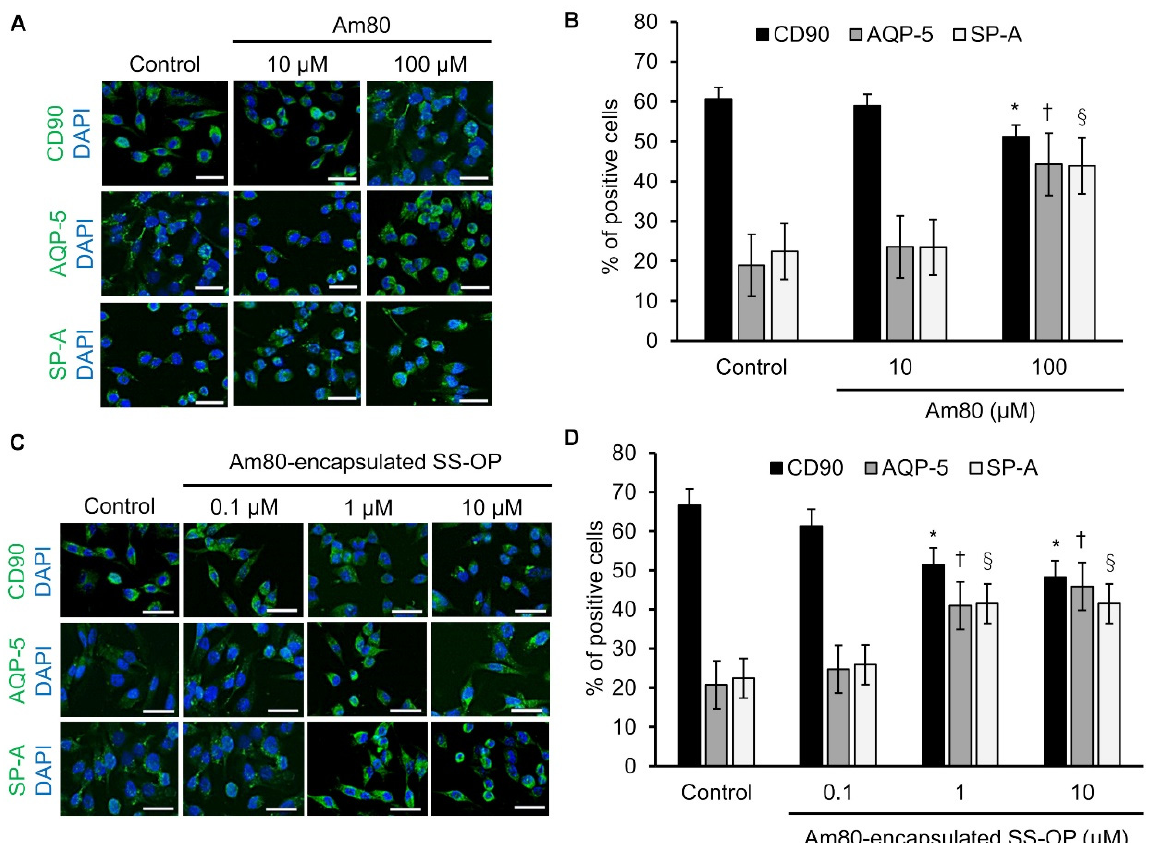
Figure 2. Am80-free or Am80-encapsulated SS-OP nanoparticles induced lung cell differentiation. Immunostaining of CD90, AQP-5, and SP-A after ( A ) the administration of free Am80 (10 and 100 µ M) or ( C ) Am80 (0.1, 1, and 10 µ M)-encapsulated SS-OP nanoparticles, which was observed by BZ9000, × 20, Scale Bar: 20 µ m. The percentage of positively stained cells. The numbers of CD90-, AQP-5-, SP-A-, and DAPI-positive cells after treatment with ( B ) free Am80 and ( D ) Am80-encapsulated SS-OP nanoparticles. Each value represents the mean ± S.D. (n = 4–5). * p < 0.05 for CD90, † p < 0.05 for AQP-5, and § p < 0.05 for SP-A group comparisons, Dunnett’s test, vs. control group.